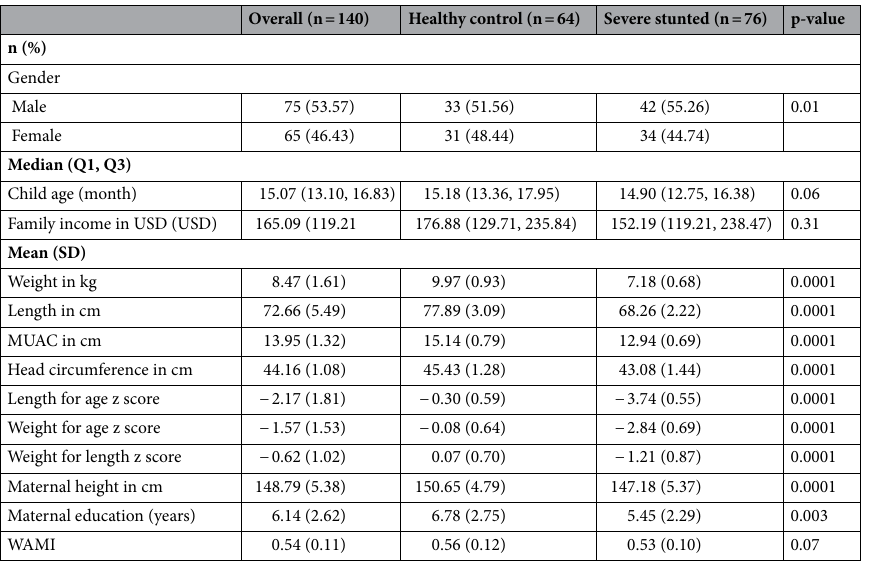
Table 1. Anthropometric and socioeconomic characteristics of the study participants.